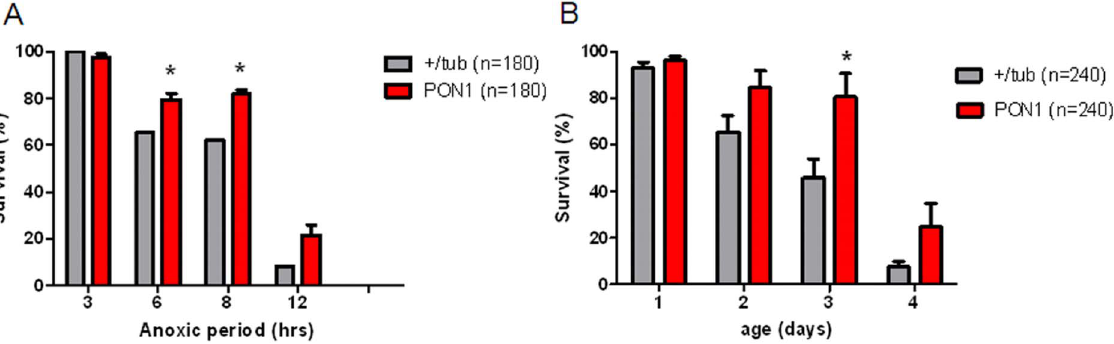
Figure 4. Survival of transgenic flies after starvation period. A) + /tub and PON transgenic flies were starved for 18 hrs and then exposed to different periods of anoxia, survival was registered 24 hrs after reoxygenation. B) + /tub and PON transgenic flies of different ages were exposed to 3 hrs of anoxia and survival was registered 24 hrs after reoxygenation. *p , 0.05 when compared with + /tub.